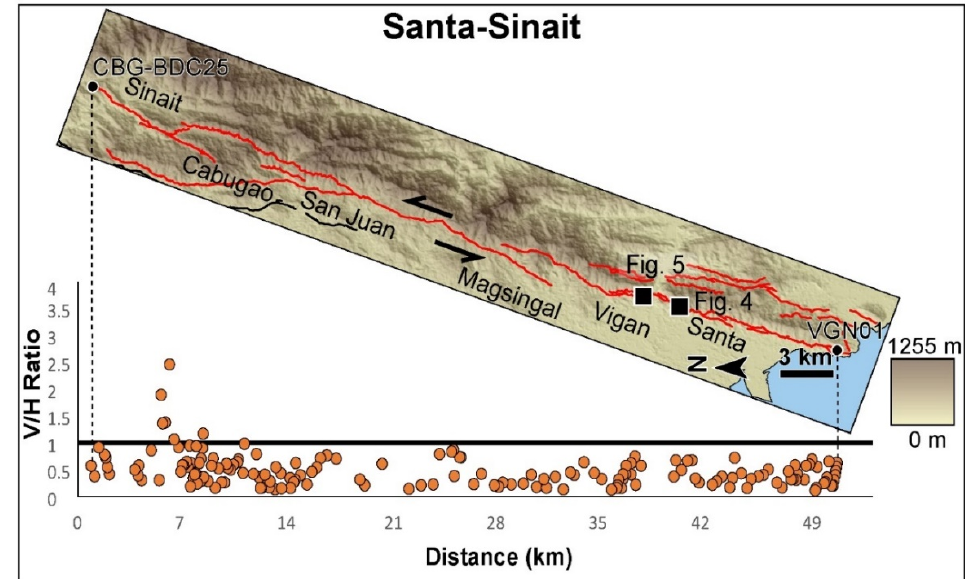
Figure 3. Map of the trace from Santa to Sinait (labeled ‘a’ in Figure 2A), south of Magsingal above the offset plot for this part of the Vigan-Aggao Fault. The Santa-Sinait segment is traced in red, while the southern portion of the San-Juan Vintar segment is traced in black.